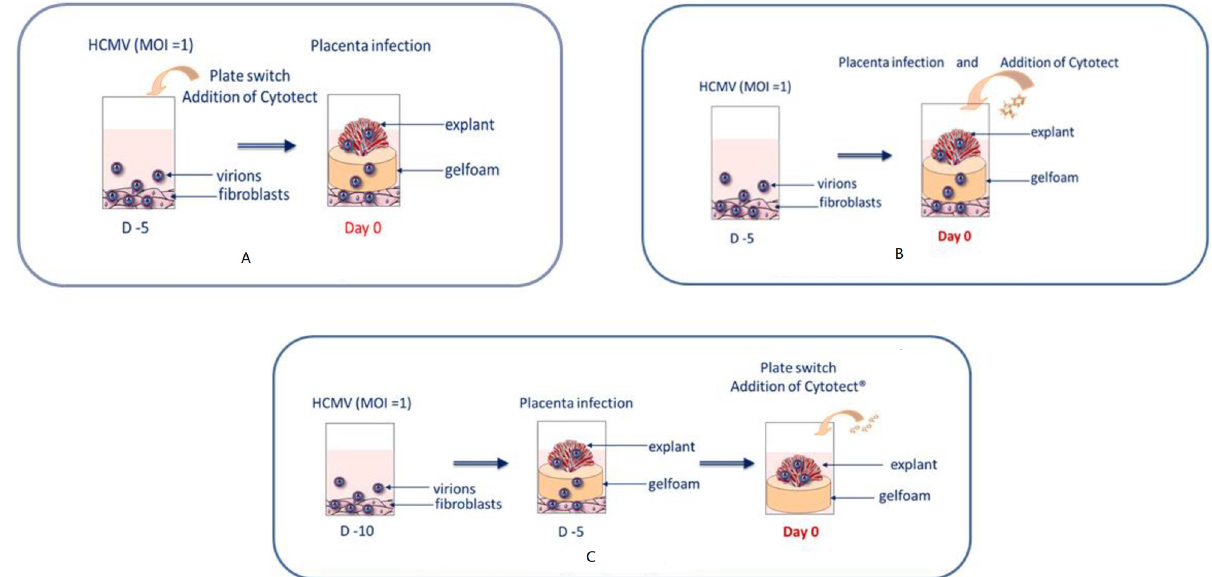
Figure 1. Ex vivo assays. Three different protocols were used to evaluate the efficacy of Cytotect CP ® . For all ex vivo assays, HEF cells were seeded into 48-well plates at 10 5 cells/well and then in- cubated for 5 days at 37 °C in 5% CO 2 until confluence. The villi explant model is based on infection from cell-free virus produced by infected fibroblasts. HEF cells were infected with cell-free virus stock of the TB40/E strain with a multiplicity of infection (MOI) of 1 in HEF culture medium. The addition of explants on a gelfoam (Spongostan dental™, NewPharma, Belgium) allowed infection by capillarity. We performed three types of assays, mimicking several real-life conditions in mater- nal blood, at the placental level, and after placental infection ( A ): Neutralization assay : The virus was neutralized by Cytotect CP ® before the addition of placental explants. TB40/E and Cytotect CP ® were incubated on an HEF plate for 3 h at 37 °C in 5% CO2 before renewing the medium. After 5 days of incubation, a sponge with a placental villi explant was added in each well and was incubated at 37 °C in 5% CO2. Day 0 was the first day of infection of the villi. ( B ): Prevention of villi infection assay : Cytotect CP ® and explants were added simultaneously after 5 days of infection of the cells. Day 0 was the first day of infection of the villi. ( C ): Efficacy assay : Villi were added after 5 days of new plates without cell monolayers and Cytotect CP ® was added. Day 0 was 5 days after placental